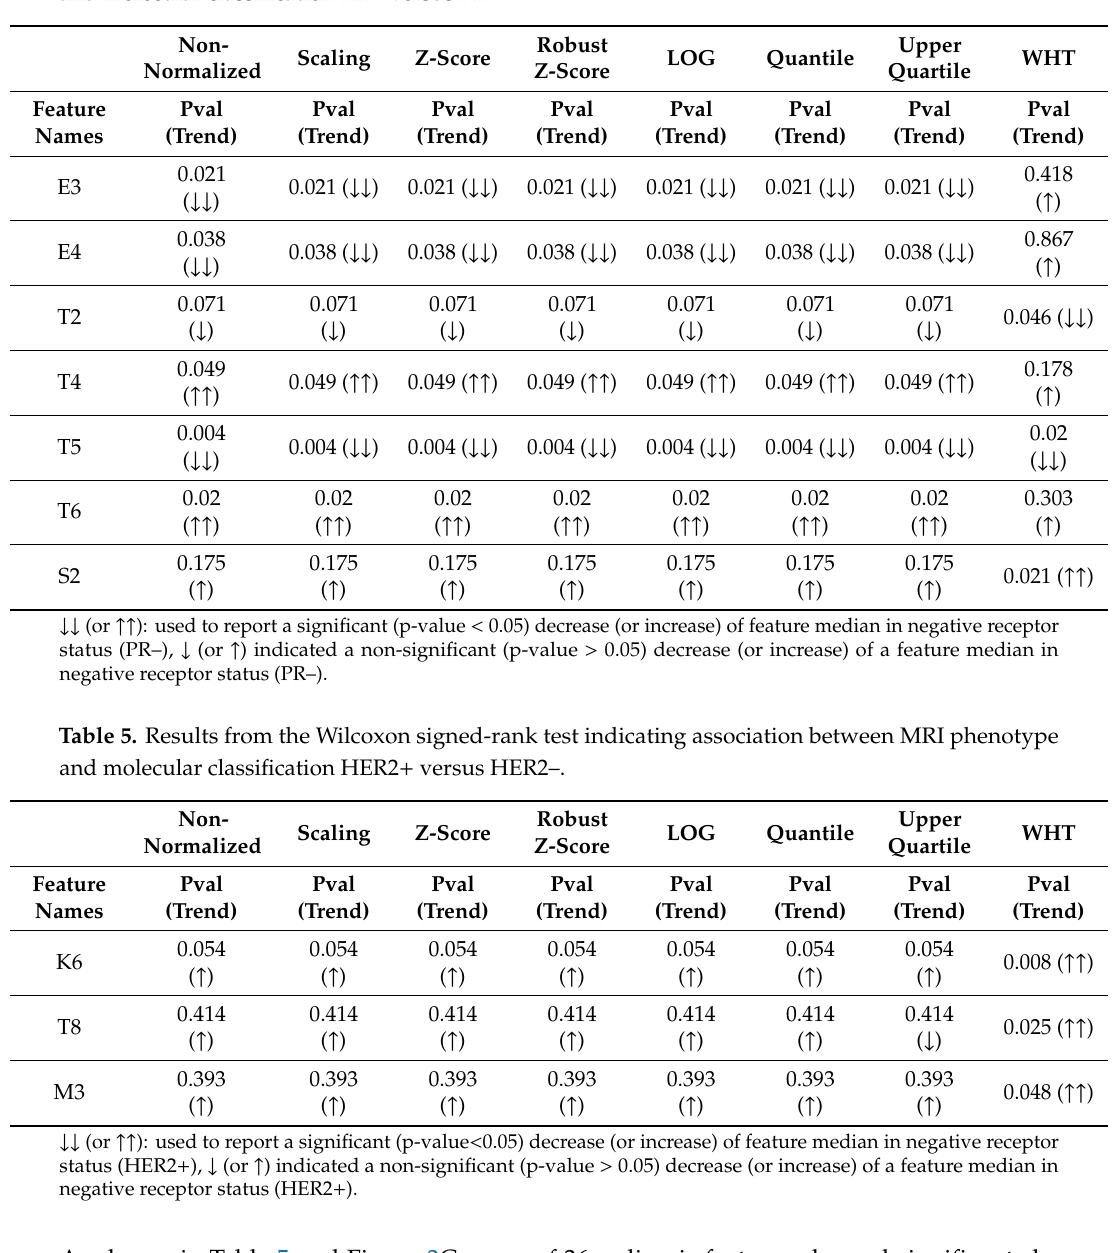
Table 4. Results from the Wilcoxon signed-rank test indicating association between MRI phenotype and molecular classification PR + versus PR.